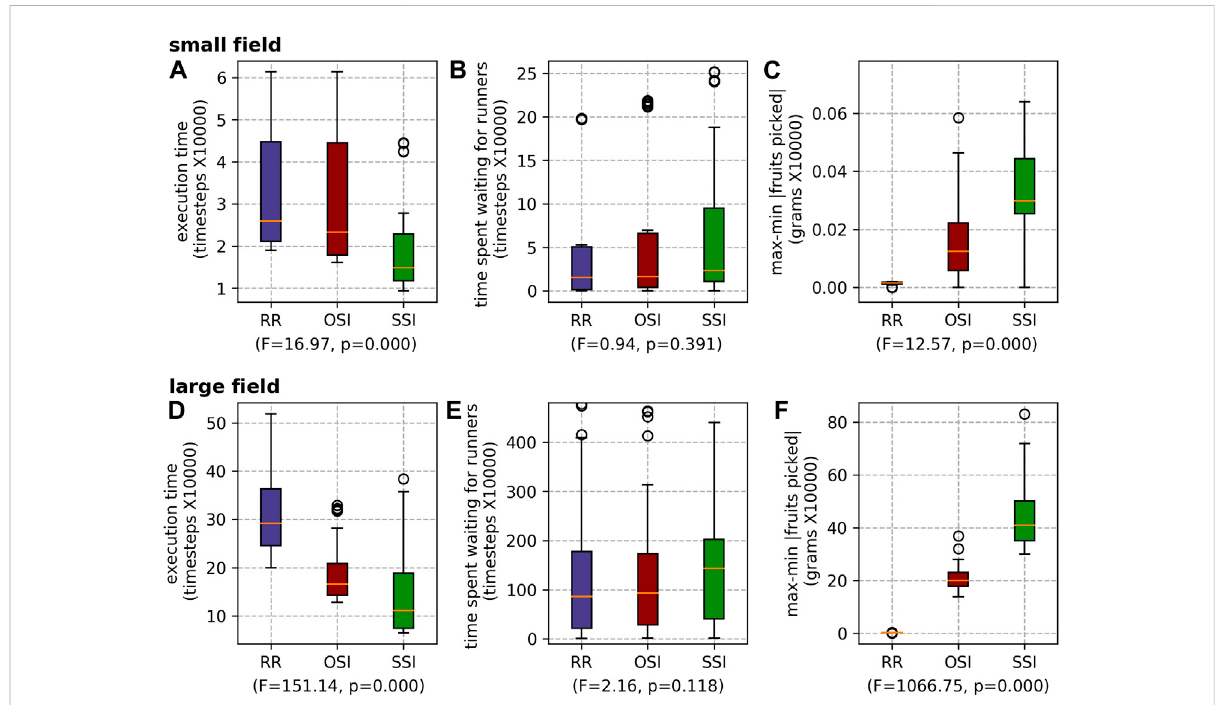
FIGURE 11 Resultsforthedifferentpickerschedulingmechanismsforbothfarms:thesmall fi eld (A) executiontime, (B) waitingtimeand (C) max-min|fruits picked|; and the large fi eld (D) execution time, (E) waiting time and (F) max-min |fruits picked|.